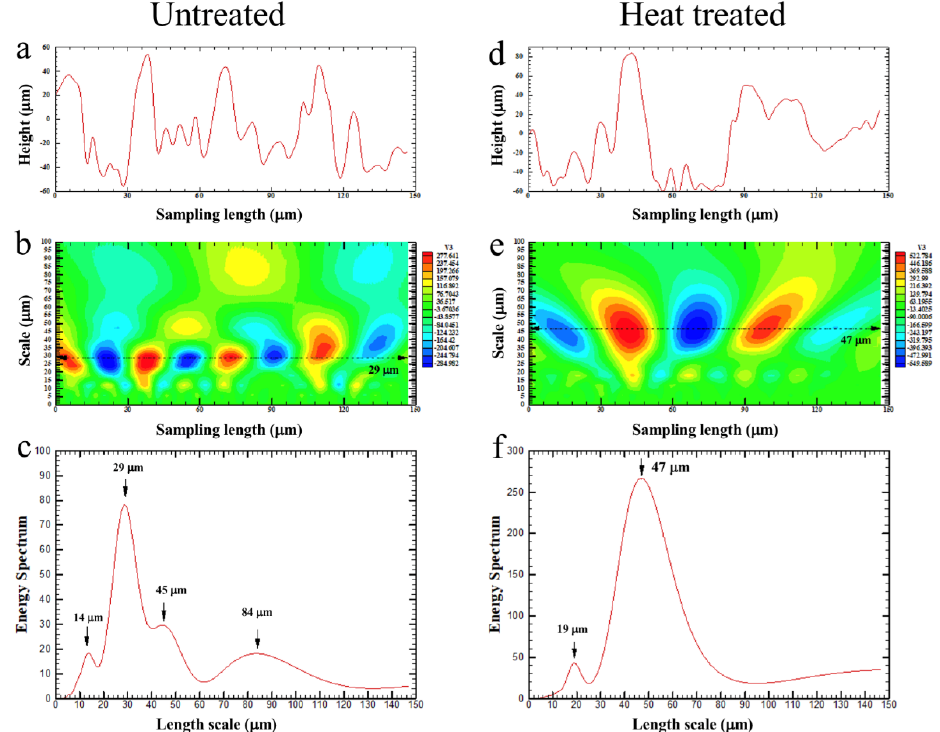
Figure 6. Wavelet-based multi-resolution analysis for the characteristic length scales of untreated and heat-treated Ti64 substrates. ( a – c )/( d – f ) respectively show the height signals, contour plots of the wavelet transform of the height signals, and the average wavelet spectra of untreated/heat-treated Ti64 specimens, where the height signals were directly obtained along the horizontal axis from the symmetry center of the position (a) and position (g) (see Figure